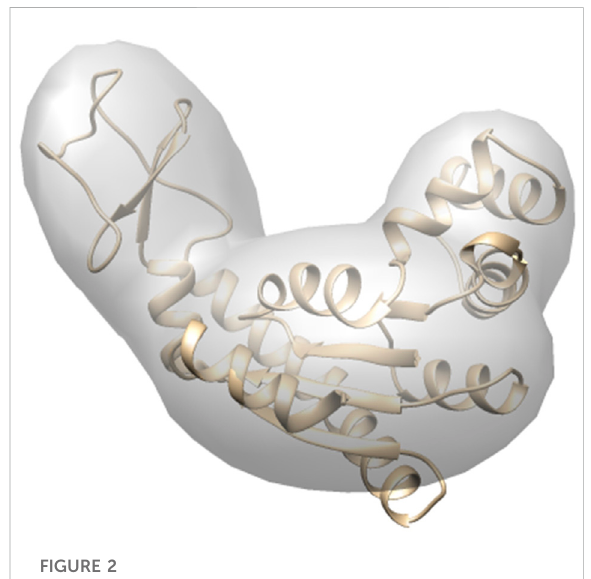
FIGURE 2 Coarse-grained model by GMM. The number of Gaussian kernels is 3, made from AK target conformation. The domains are de fi ned according to Table 1. The 3 individual kernels are shown with the embedded atomic structure. The kernels were rendered by UCSF Chimera (Pettersen et al.,